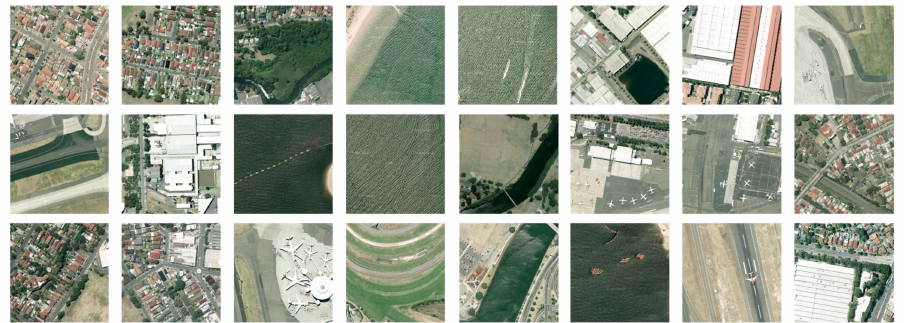
Figure 6. Some samples selected from the Sydney-Captions dataset, including factories, grassland, houses, runways, etc. The Sydney-Captions dataset contains samples of a total of seven scenes. The size of each remote sensing sample is 500 × 500, and the format is